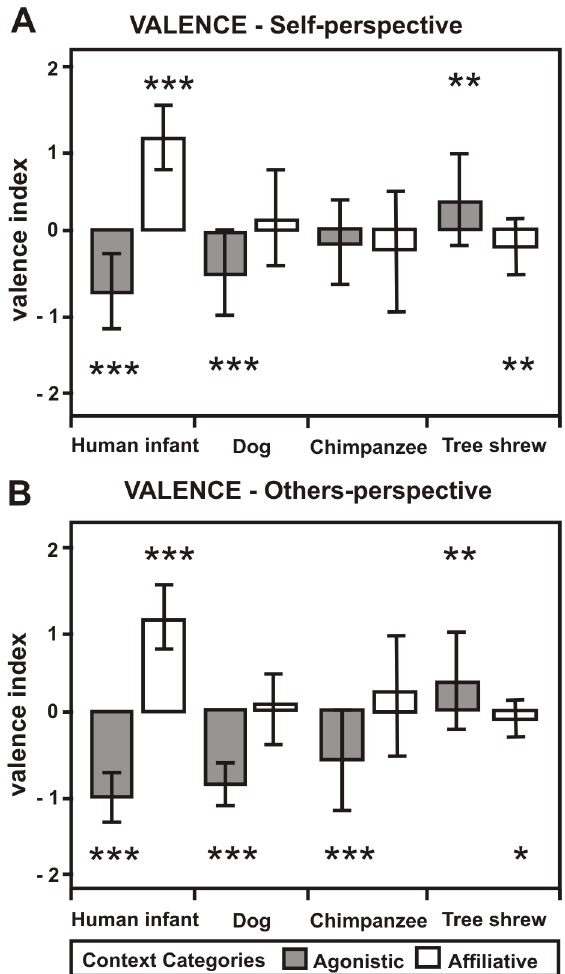
Figure 3. Valence ratings for the playback categories. Mean and standard deviation of the valence index for the playback categories of the (A) self-perspective and the (B) others- perspective. one-sample t- test *** p # 0.001, **p # 0.01, *p #